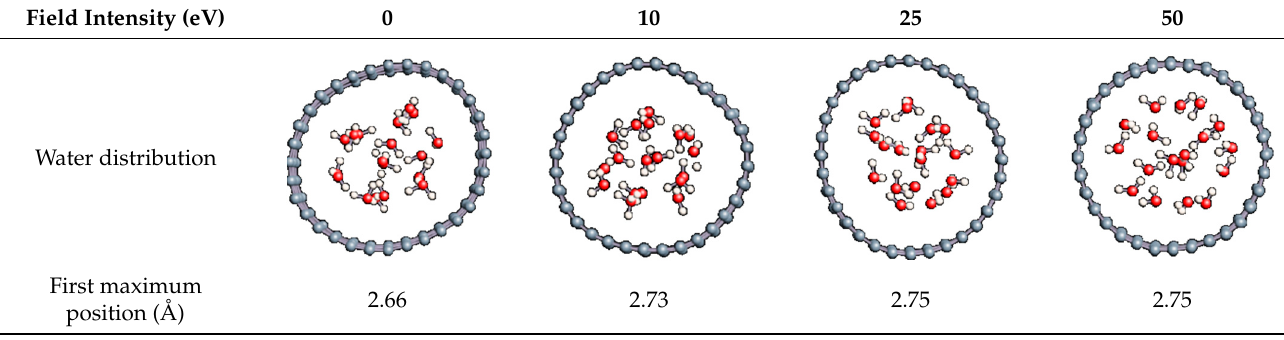
Table 9. Distribution of water inside the (16,0) carbon nanotube.